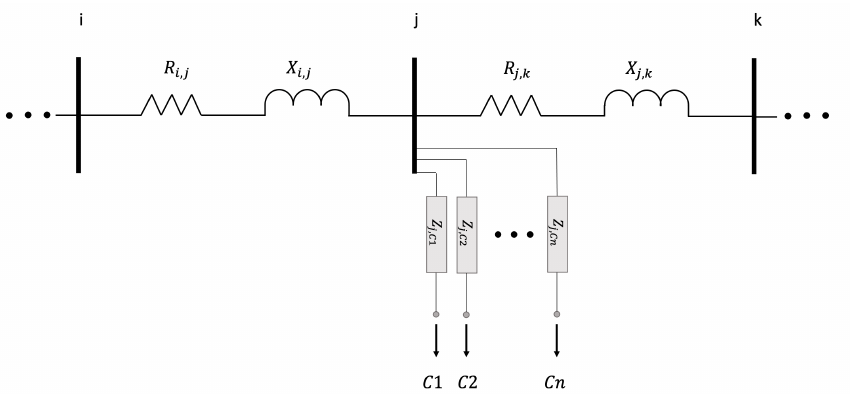
Figure 1. Feeder lateral example where i and k correspond to standard network load buses and j corresponds to a node to which feeder laterals are connected to supply consumers 1,2, . . ., n